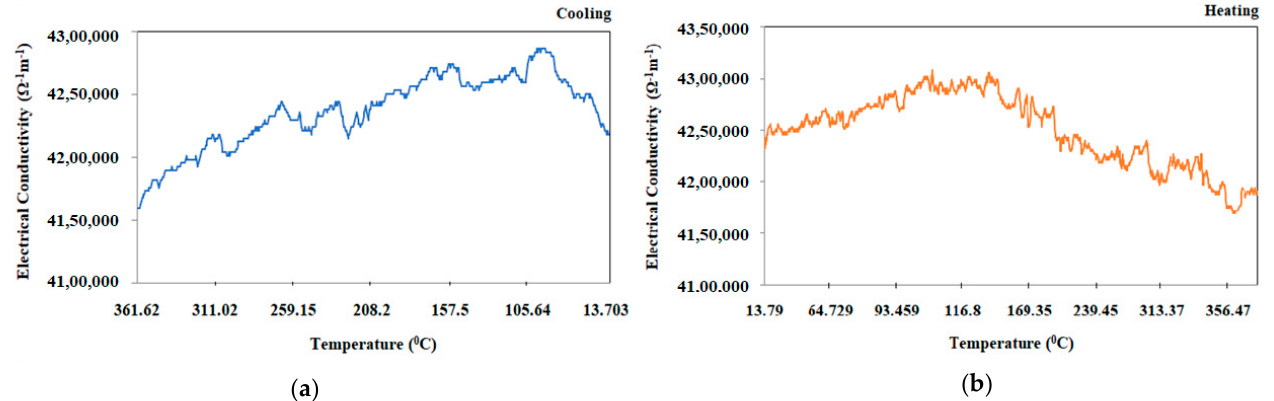
Figure 9. Electrical conductivity versus temperature for Ti-6Al-4V-SiC (15 Wt.%) specimen processed